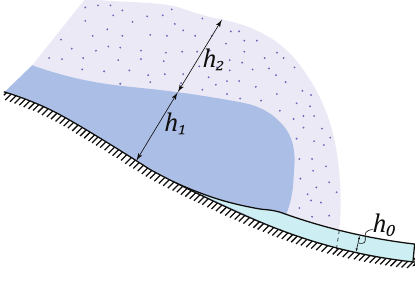
Figure 9. Scheme of mixed